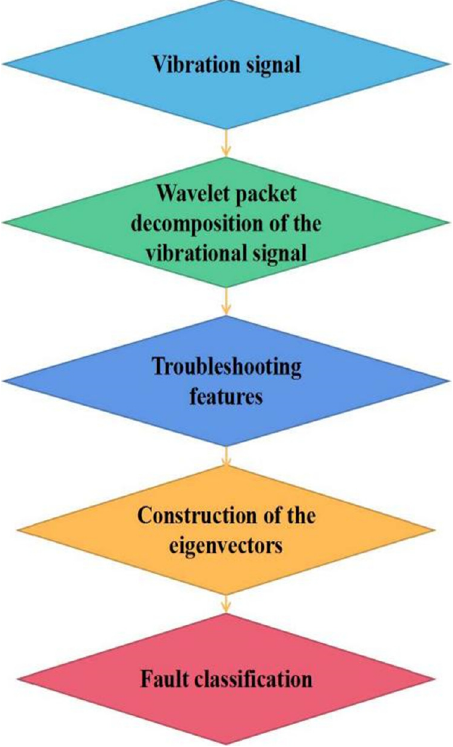
Figure 2: Mechanical equipment fault feature extraction